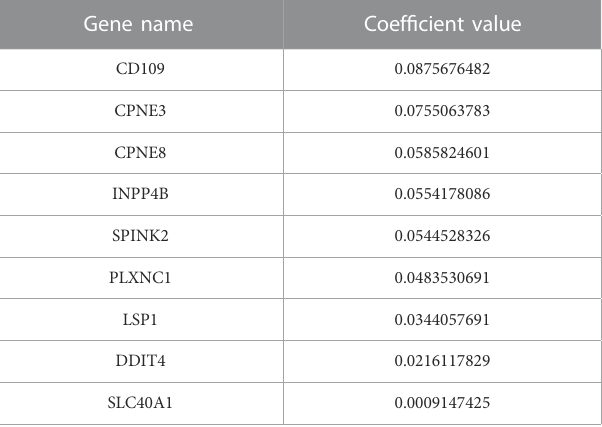
TABLE 2 Nine prognostic genes with positive coef fi cient